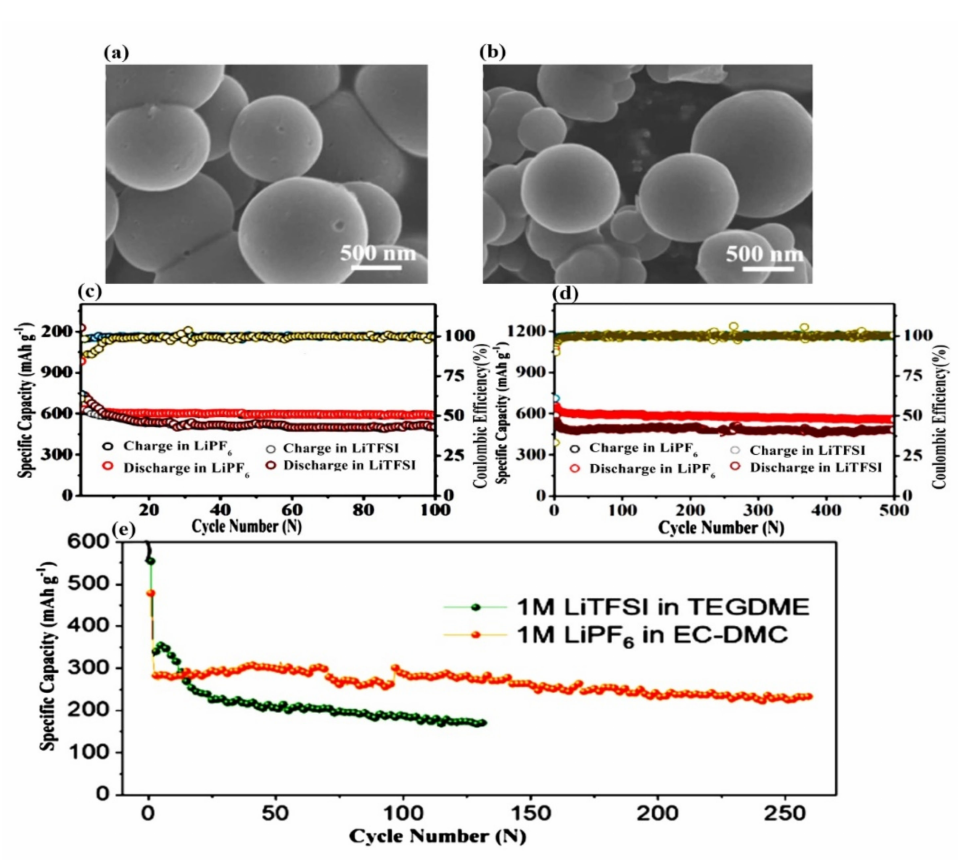
Figure 3. SEM images of ( a ) the carbon material of MPCSs, ( b ) the MPCS/Se composites. Cycling performance of MPCS/Se composites at ( c ) 0.2 C, ( d ) 1 C. Reproduced with permission from [33], Copyright 2021, Elsevier BV. ( e ) Cycling performance of Se/KB composites at 0.2 C current density. Reproduced with permission from [29], Copyright 2021, Elsevier